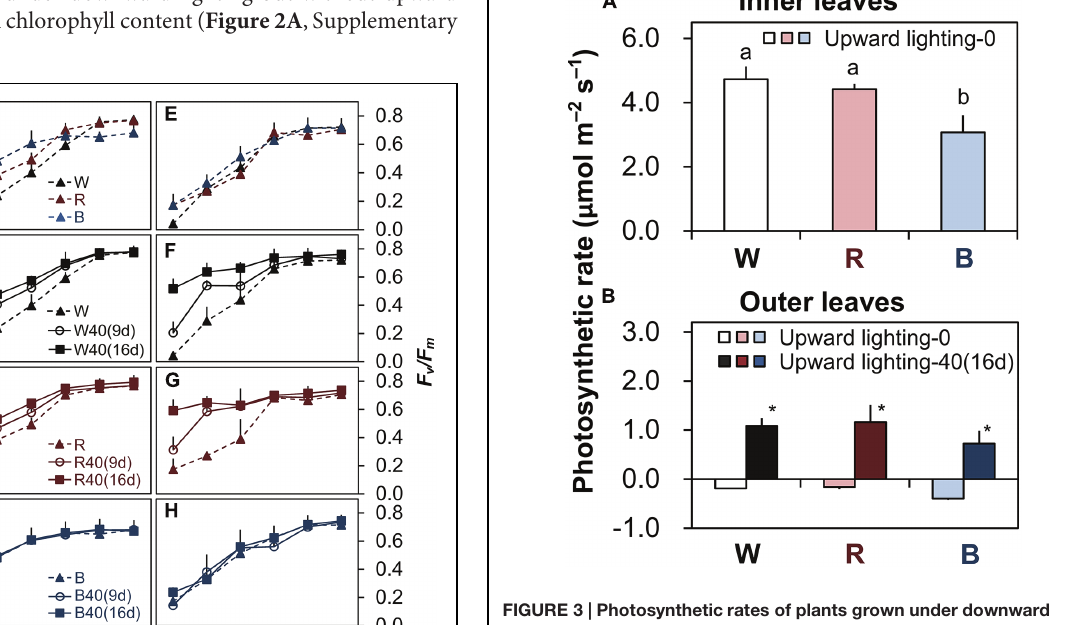
FIGURE 3 | Photosynthetic rates of plants grown under downward lighting by white, red, or blue LEDs, with or without supplemental upward lighting. Data represent means ± SD ( n = 3). (A) Photosynthetic rates were measured under ambient light conditions in the most newly expanded leaves (in the sixth layer) in plants grown without upward lighting. Bars labeled with different letters differ significantly (Tukey’s HSD test, P < 0.05) among the three light colors. (B) Photosynthetic rates were measured under ambient light conditions in the outer leaves (in the third layer) in plants grown under downward lighting by white, red, or blue LEDs, with or without supplemental upward lighting for 16 days. Bars labeled with “ ∗ ” differ significantly for a given light color (Student’s t -test, P < 0.05). “Upward lighting-0” denotes plants grown without supplemantal upward lighting; “Upward lighting-40 (16d)” denotes plants grown with 16 days of supplemental upward lighting at 40 µ mol m − 2 s − 1